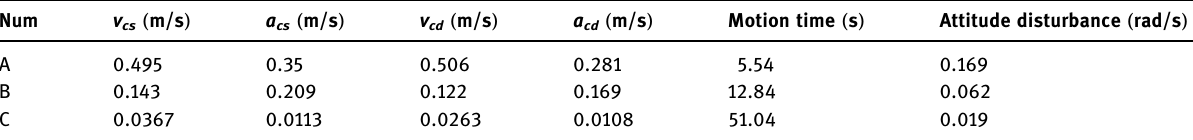
Table 1: Variables and objective function values of typical solutions